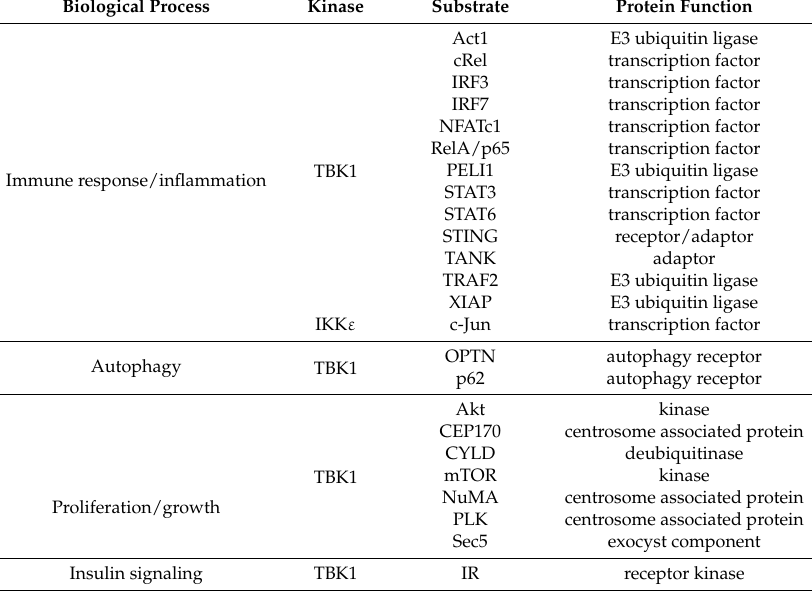
Table 1. Substrates of IKK-related kinases. The IKK-related kinases regulate biological processes through several different substrates. Act1, NF- κ B activator 1; cRel, proto-oncogene; IRF3, interferon regulatory factor 3; IRF7, interferon regulatory factor 7; p65/RelA, NF- κ B p65/RelA subunit; PELI1, Pellino-1; STAT6, signal transducer and activator of transcription 6; STING, stimulator of IFN genes; TANK, TRAF-associated NF- κ B activator; TBK1, Tank-binding kinase 1; XIAP, X-linked inhibitor of apoptosis protein; OPTN, Optineurin; p62, Sequestosome-1; Akt, Akt-1; CEP170, centrosomal